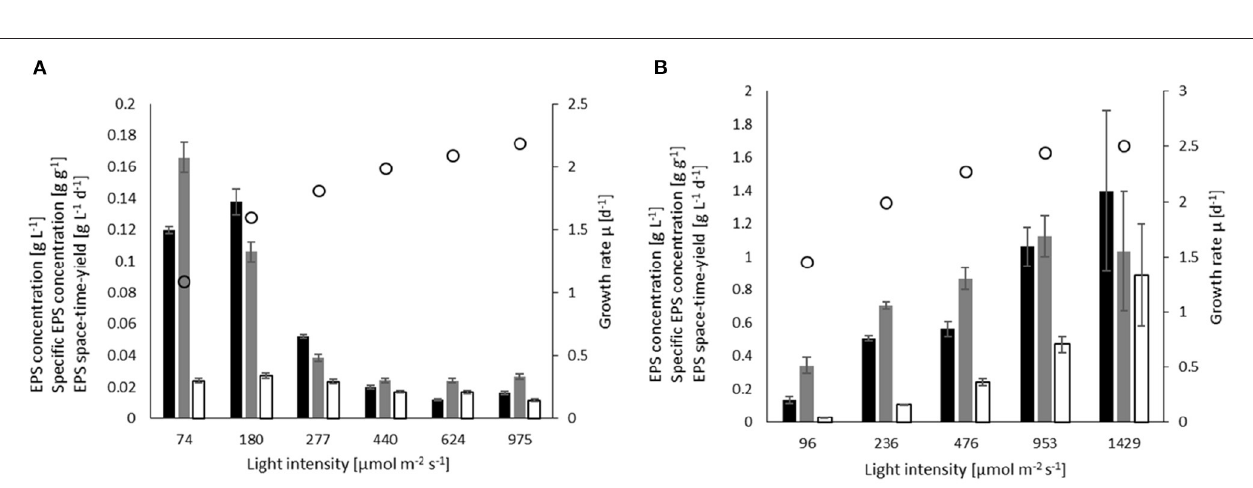
FIGURE 3 | Influence of light on the EPS concentration (black), EPS yield (gray), space-time yield (white), and specific growth (white circles) in batch processes for (A) A. platensis cultivated at 35 ◦ C, and (B) C. asymmetrica cultivated at 30 ◦ C.